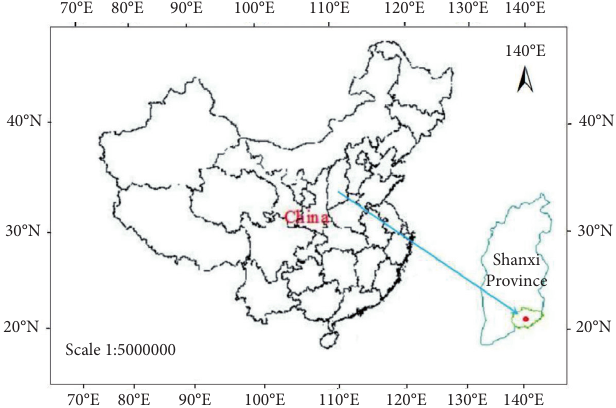
Figure 1: Location of the study area, Jincheng City, Shanxi Province, China.